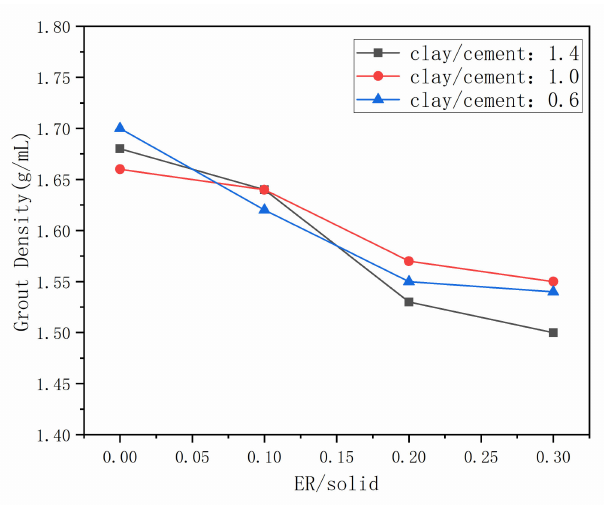
Figure 2. The density of